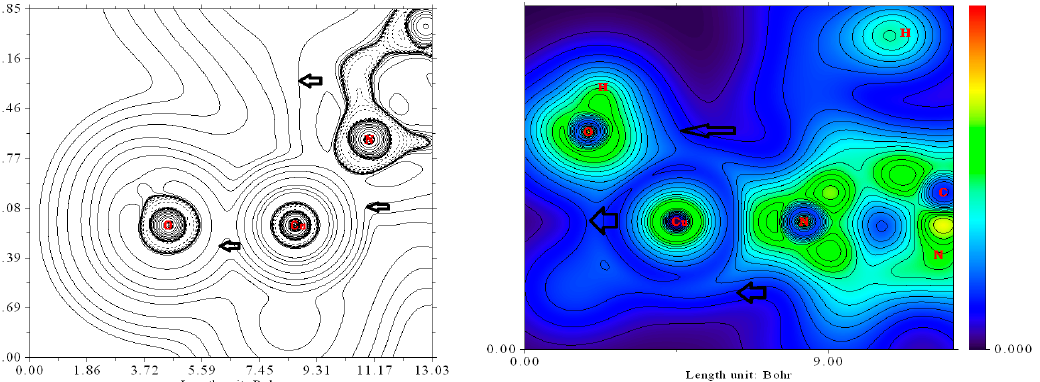
Figure 15. Contour map of electron density ( left ) Laplacian and localized-orbital locator (LOL) ( right ).